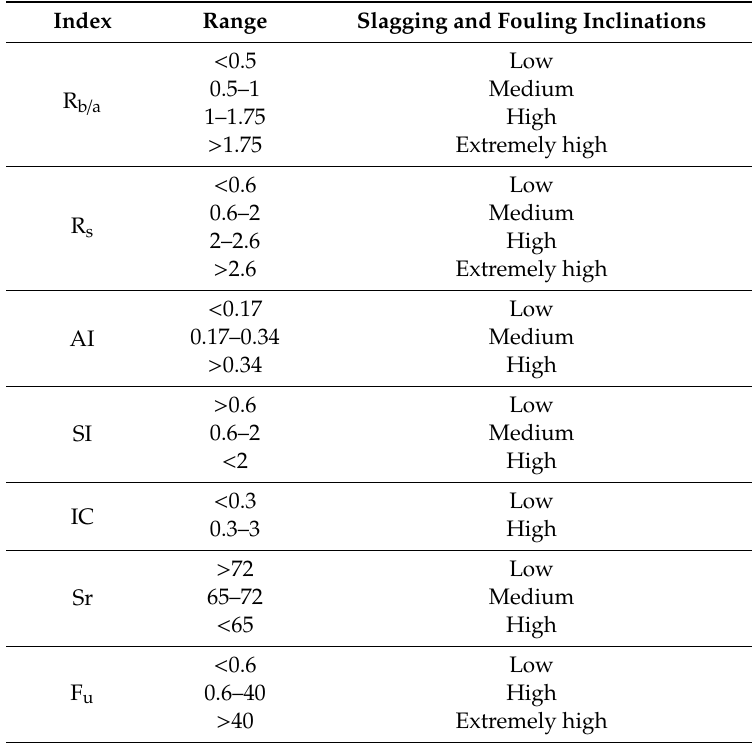
Table 1. Relationships between indicator values and levels of slagging and fouling tendencies